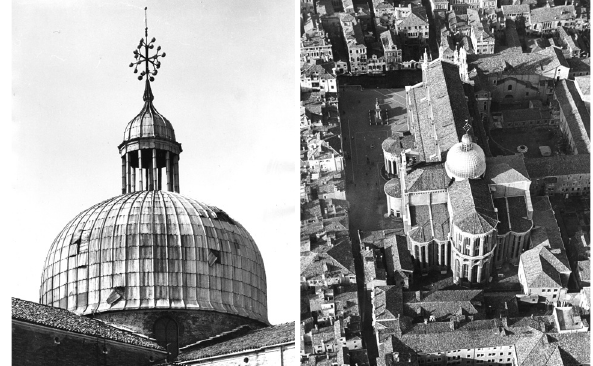
Figure 2. Historical dome's images of the second half of the XX century.